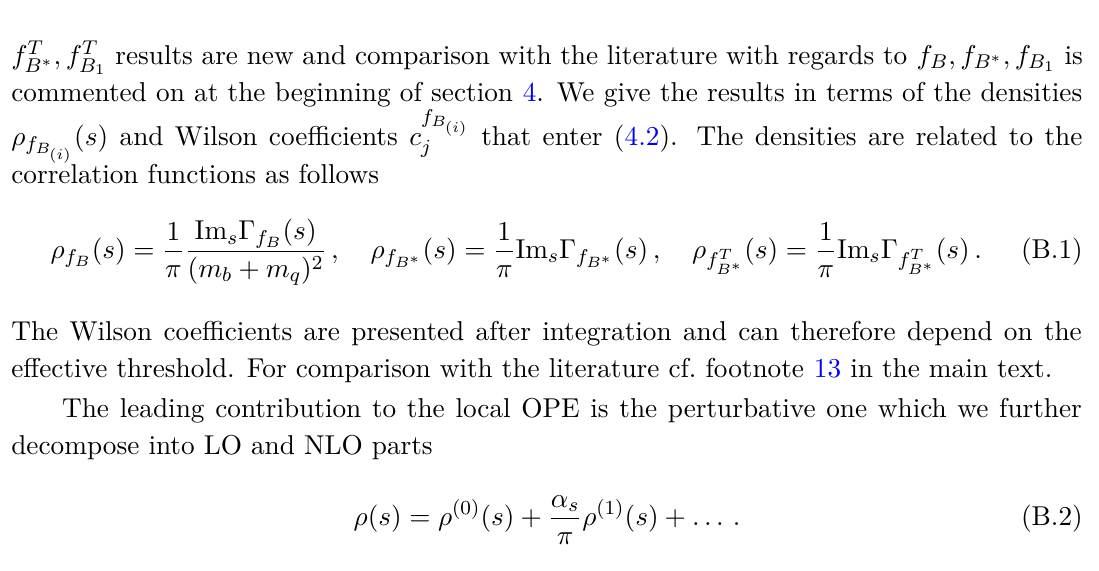
Table 14 . Summary of input parameters. † Value obtained by using the O ( α 2 the MS and the kinetic mass given in [38]. The uncertainty is obtained by adding in quadrature the uncertainty due to the MS mass and the conversion formula. For the meson masses we have not indicated an uncertainty as they are negligible. We refer to [3] for all the input concerning the photon DA that enters the light-cone sum rule